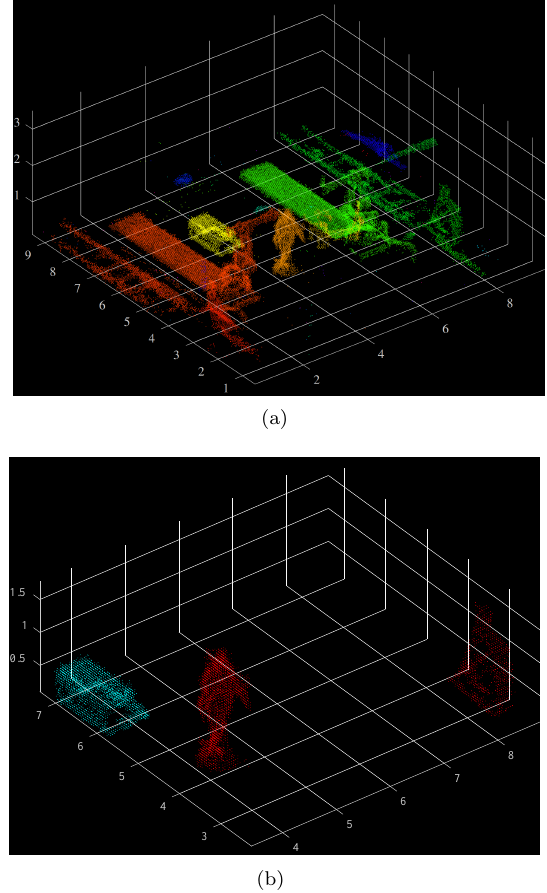
Figure 2: ( a ) Candidate clusters after segmentation, but before dimension constraints; ( b ) Can- didate clusters after dimension constraints have been